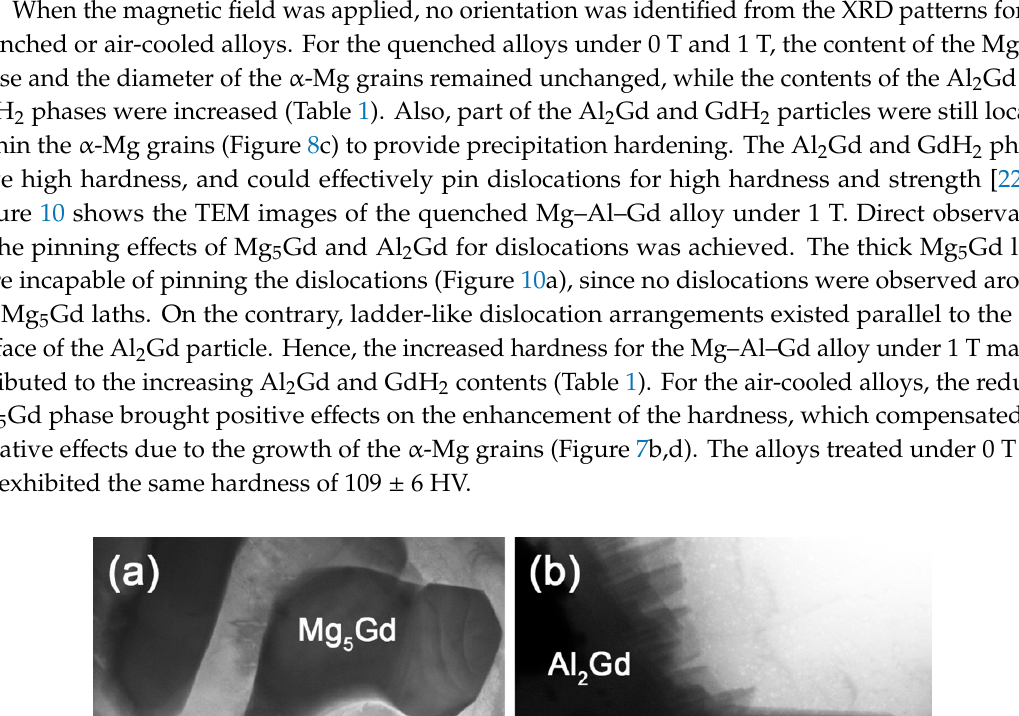
Figure 9. Vickers hardness of the quenched, air ‐ cooled and furnace ‐ cooled Mg–Al–Gd alloys under 0 T and 1 T.